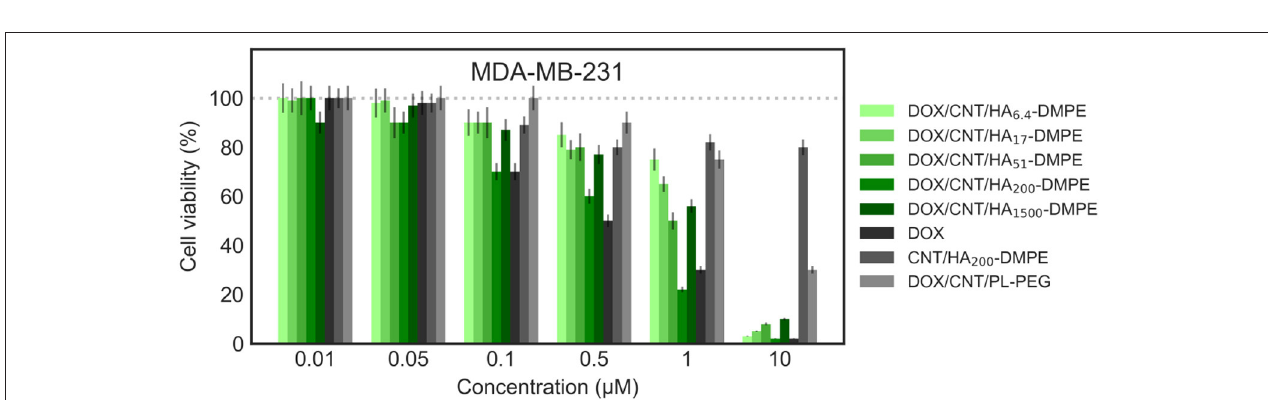
FIGURE 10 | Viability of the MDA-MB-231 (CD44 + ) cell line when treated with various formulations at different concentrations for 24h. Cell viability was determined using the sulforhodamine B (SRB) assay as previously described in material and methods section.